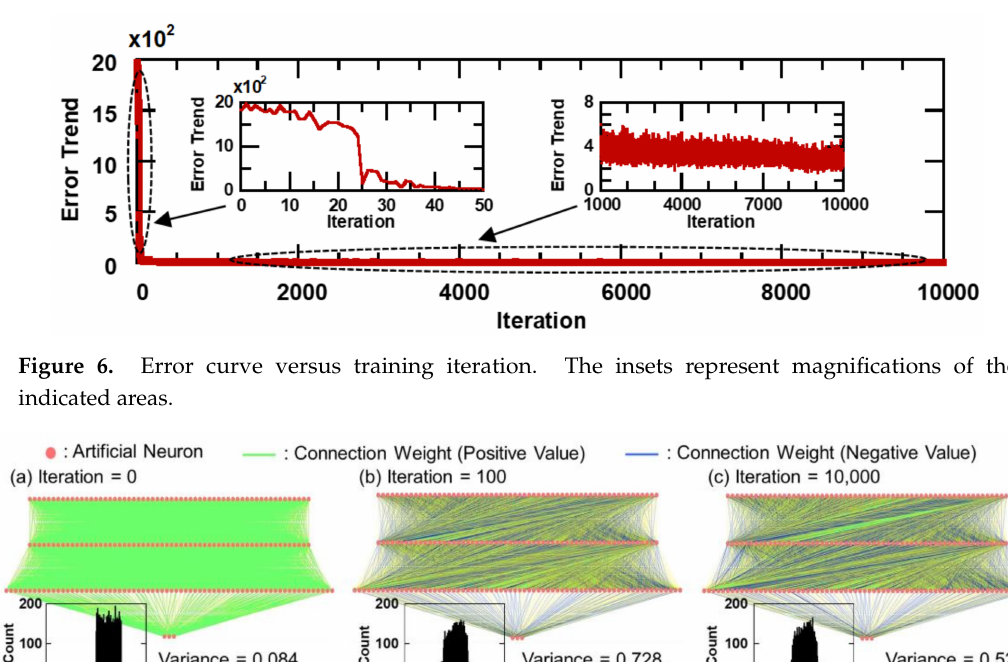
Figure 5. Five training datasets for the ( a ) index finger, ( b ) middle finger, and ( c ) little finger motions, respectively.